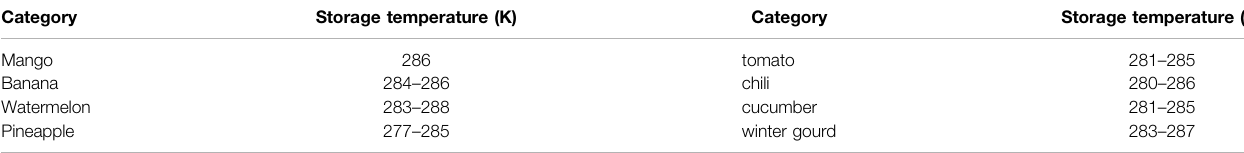
TABLE 1 | The fresh-keeping temperature of several common fruits and vegetables (Wenku Baidu, 2021).